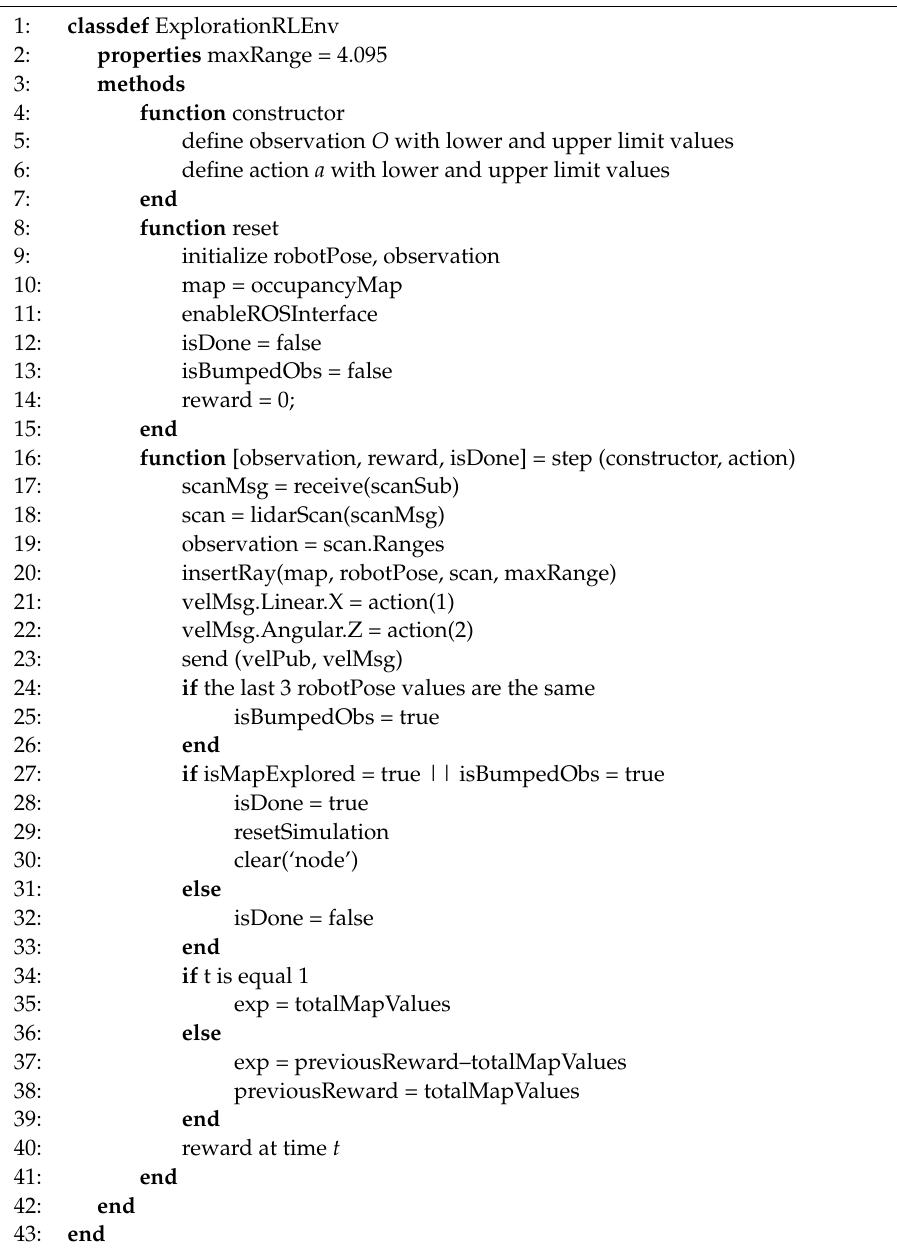
Algorithm 1: The RL environment for the mobile-robot